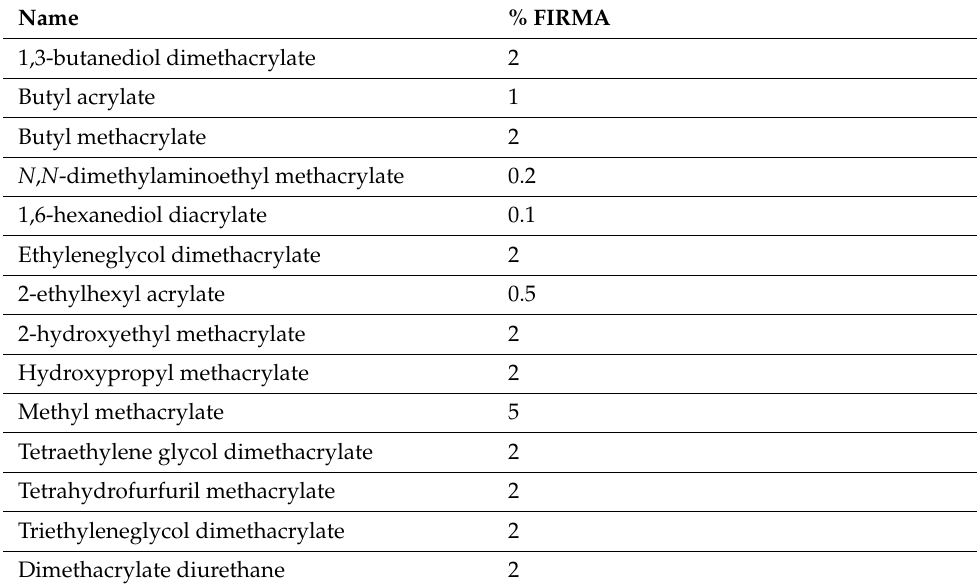
Table 3. Methacrylate series (FIRMA) patch test-positive